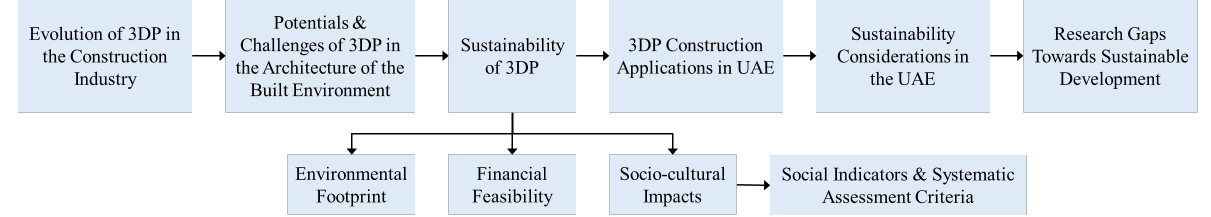
Figure 3. Relevant publications based on geographic location.